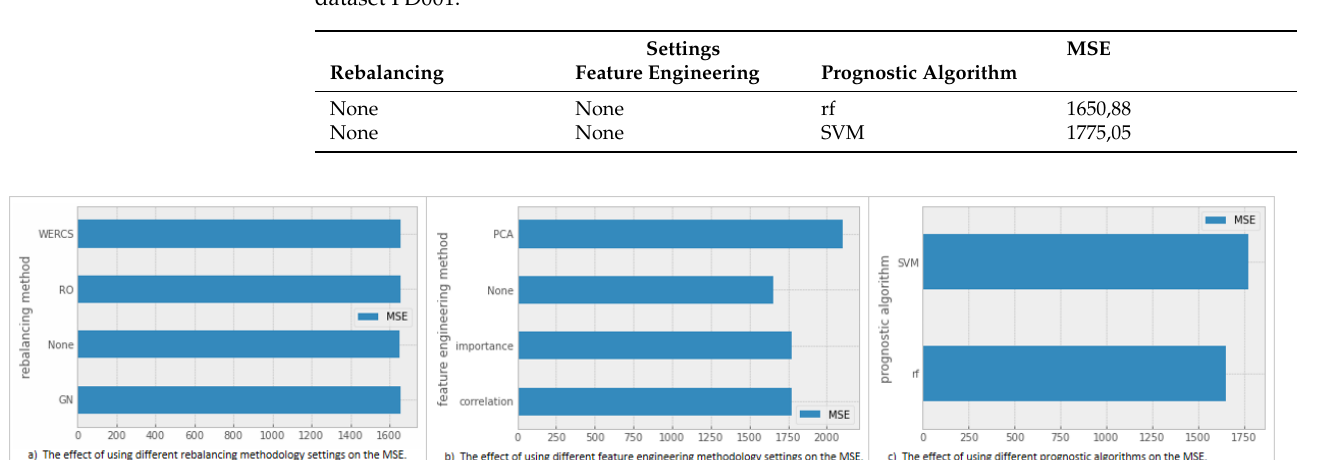
Figure 8. A comparison of applying the different prognostic settings on dataset FD001.